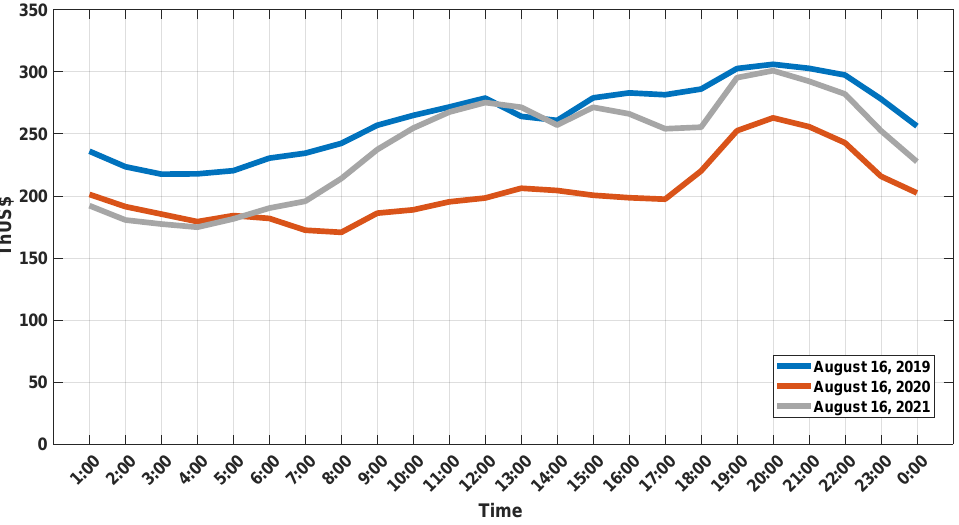
Figure 24. Optimal cost of electricity production by